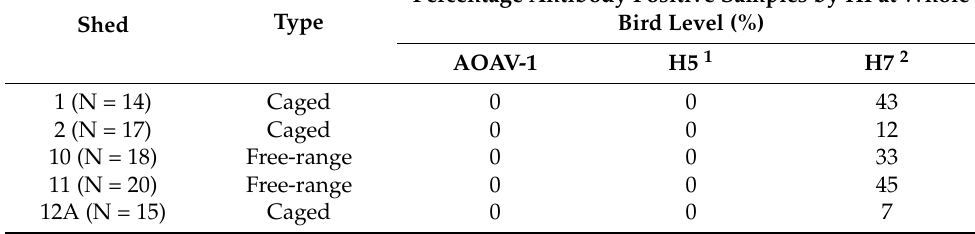
Table 5. Hemagglutination inhibition (HI) results from Sample Set 2. The number of sera tested from each shed is provided in